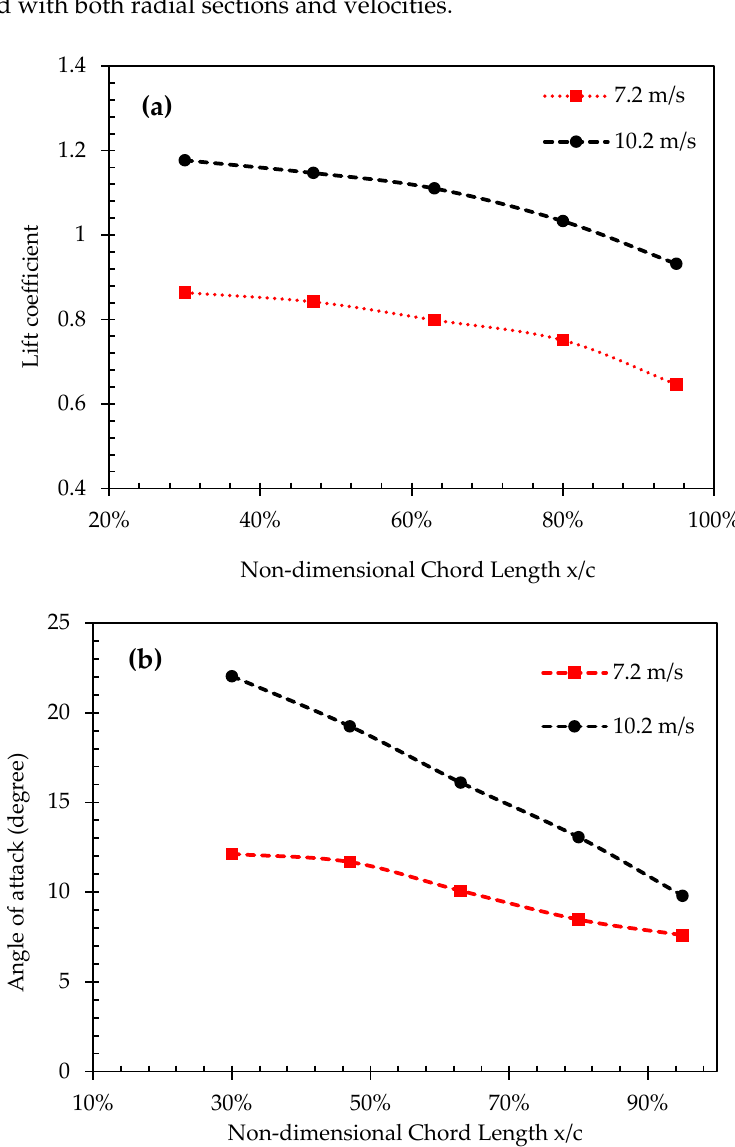
Figure 9. ( a ) Variation of lift coe ffi cient with di ff erent non-dimensional chord length sections along the blade. ( b ) Variation of the angle of attack with di ff erent non-dimensional chord length sections along the blade.